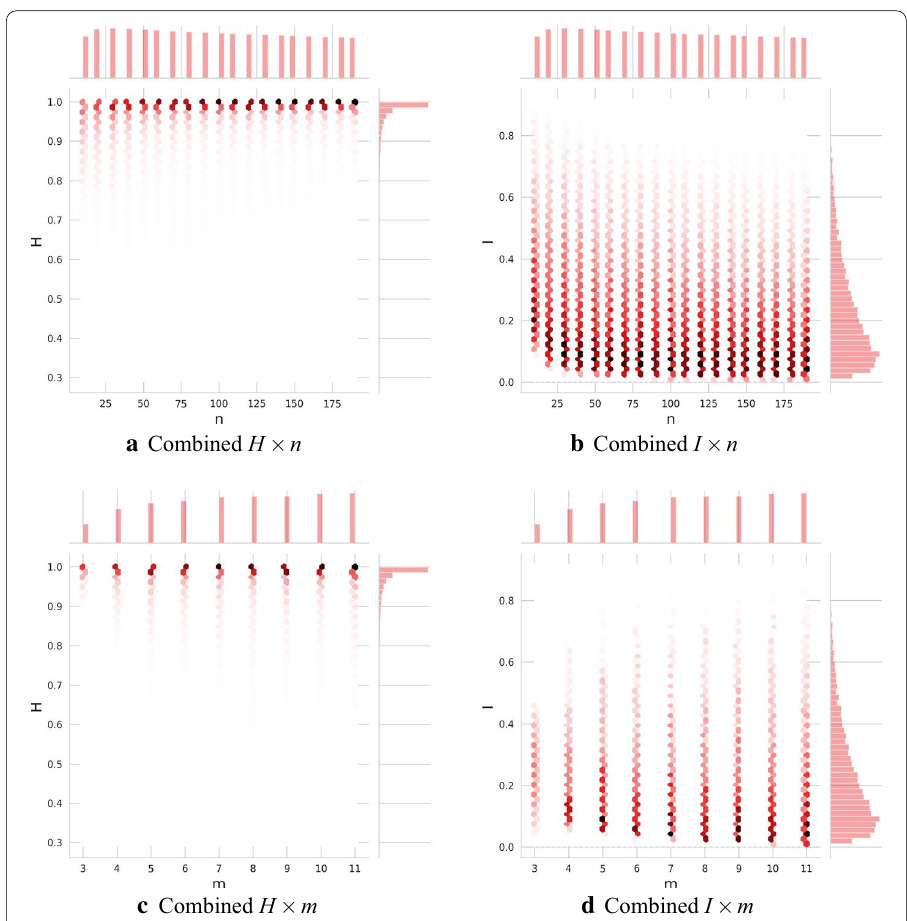
Fig. 23 Dependency on the number of nodes and layers on the combined layers